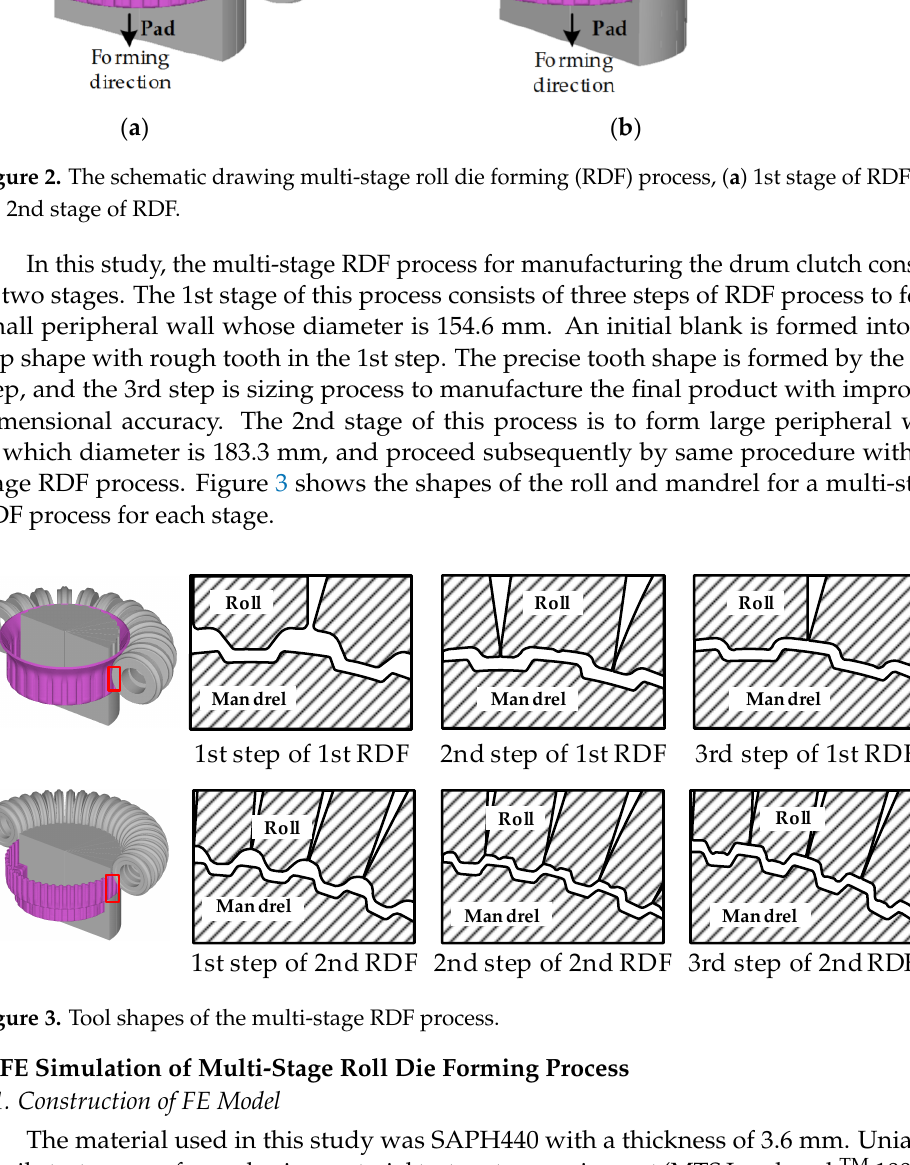
Figure 3. Tool shapes of the multi-stage RDF process.